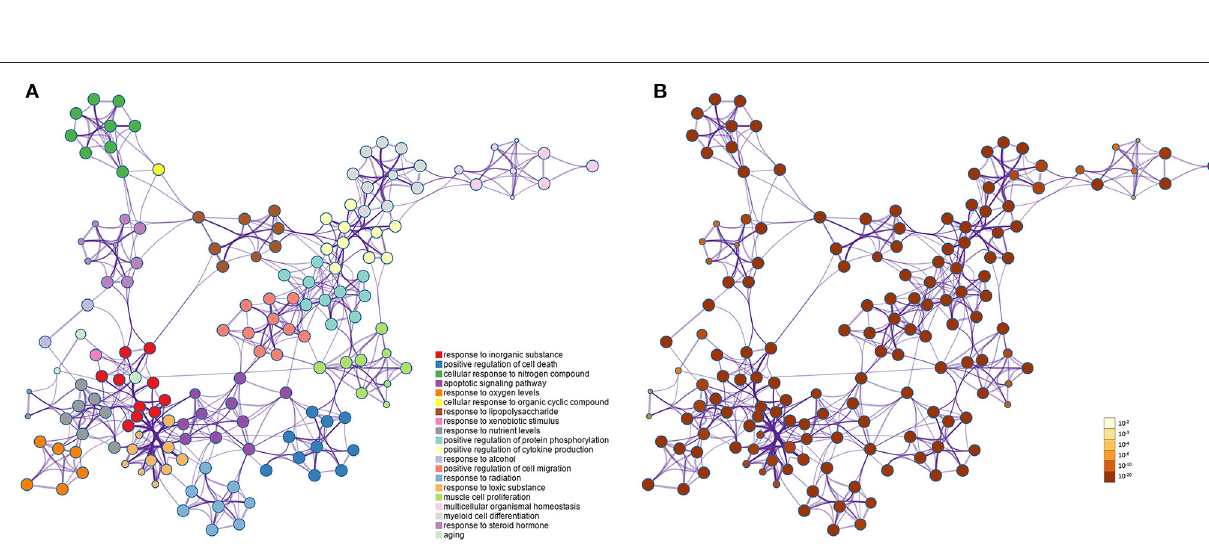
FIGURE 3 | The targets of CR for the treatment of AD. (A) The targets of AD. (B) The Common targets between CR and AD.